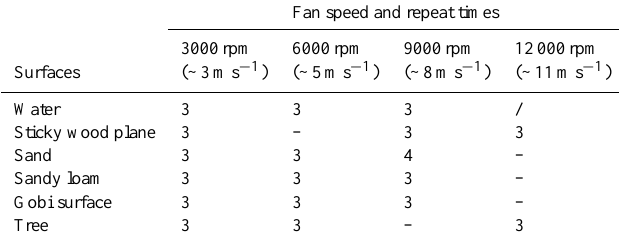
Table B1. List of wind-tunnel experiments.